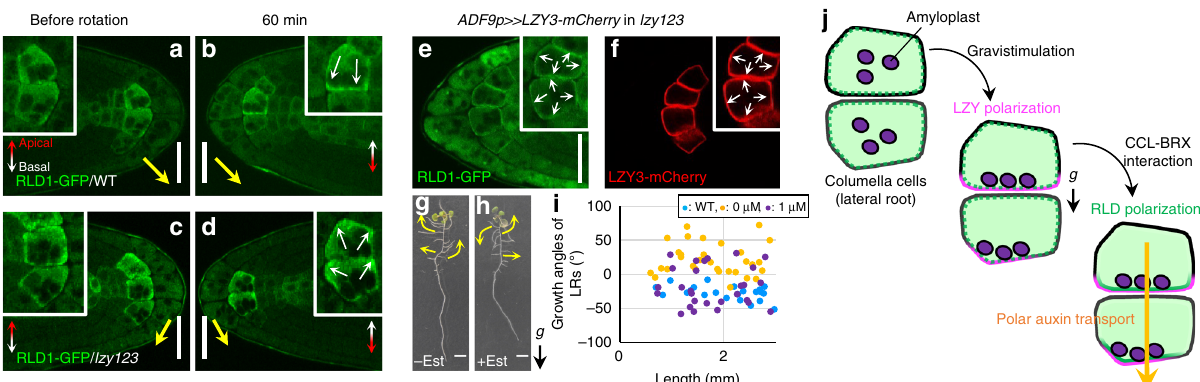
Fig. 7 LZYs control RLD1 localization in columella cells of LRs. a – d LZY-dependent RLD localization to the gravity direction. The RLD1-GFP localization in LRs of 8-day-old Col ( a , b ) and lzy1 lzy2 lzy3 ( c , d ) seedlings harboring RLD1p:RLD1-GFP before rotation ( a , c ) and at 60 min ( b , d ) after 180° rotation. White arrows indicate asymmetric localization of RLD1-GFP. Yellow arrows indicate the direction of gravity predicted from the growth angle of LRs vertically grown or after rotation. Double-headed arrows show apical – basal axis of plant body. e , f Nonpolar localization of RLD1-GFP ( e ) and LZY3-mCherry ( f ) in columella cells of LRs of 8-day-old lzy1 lzy2 lzy3 seedlings harboring RLD1p:RLD1-GFP and ADF9p:XVE»LZY3-mCherry , treated with 1 μ M estradiol for 48 h, at 60 min after 180° rotation. g , h Twelve-day-old seedling harboring ADF9p:XVE»LZY3-mCherry without ( g ) and with the treatment with 1 μ M estradiol ( h ). Yellow arrows indicate the direction of LR growth. i Scatterplots of length and growth angle of LRs (<3.0 mm) of 10-day-old plants, Col (blue), lzy1 lzy2 lzy3 harboring ADF9p:XVE»LZY3-mCherry after treatment with EtOH (orange) and 1 μ M estradiol (purple) at 4 days. Source data from three biologically independent experiments are provided as a Source Data fi le. j Schematic diagrams of LZY-RLD-mediated gravity signaling in columella cells of LR. Scale bars, 20 μ m ( a – f ) and 1 cm ( g , h